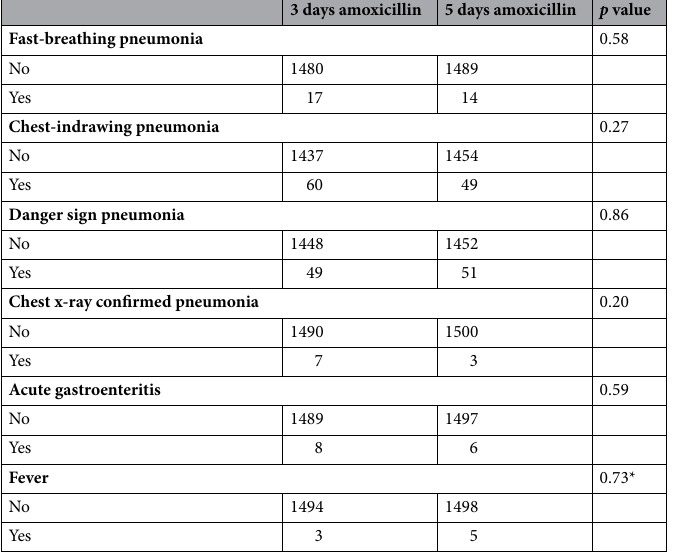
Table 2. Number of children with serious adverse events (SAEs) by treatment group. *Based on Fisher’s exact test.